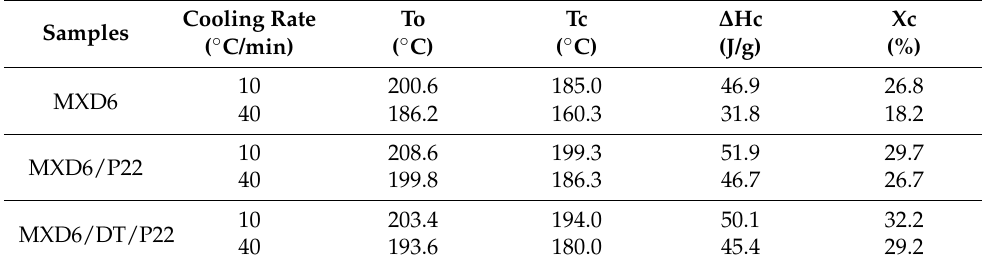
Table 2. The non-isothermal crystallization results of neat and modified MXD6.